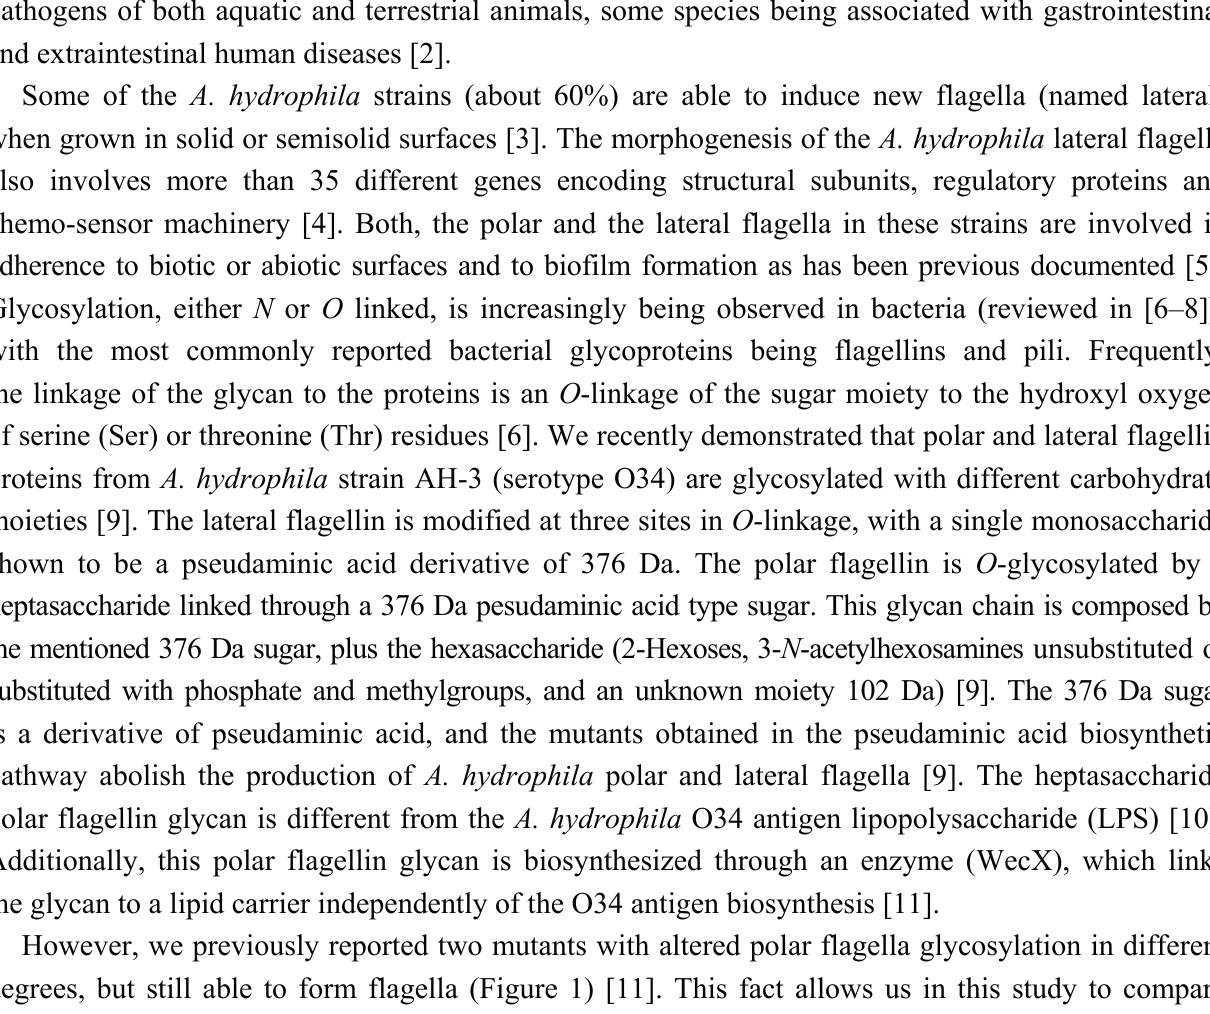
Figure 1. ( A ) Electron microscopy of whole cells from A. hydrophila strains